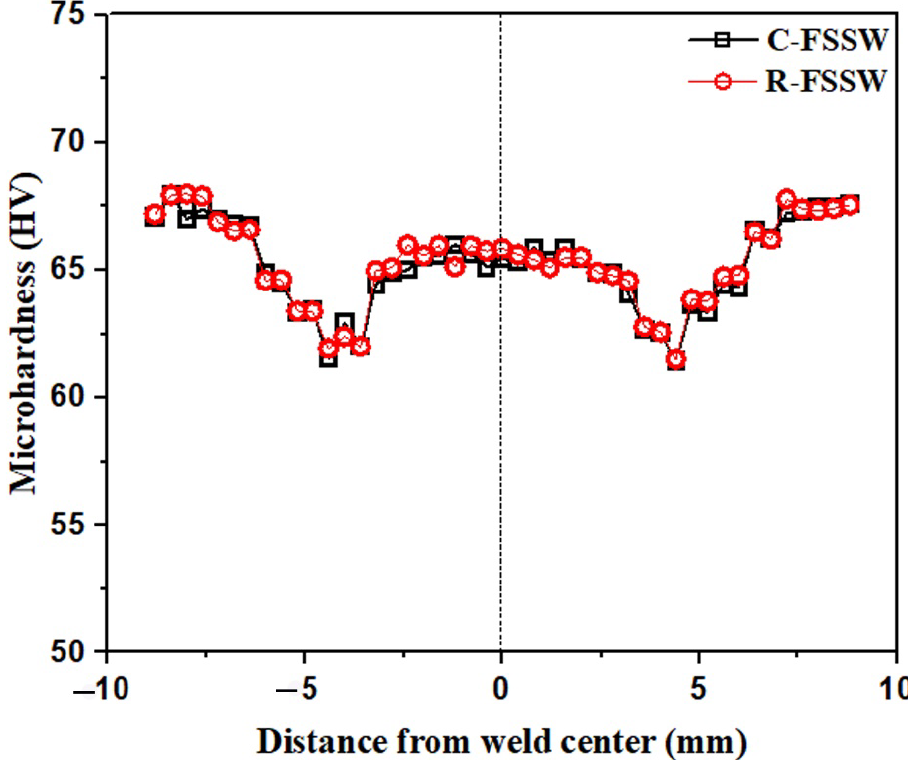
Figure 4. Hardness profile of the C-FSSW and R-FSSW joints across the weld interface. Under lap shear tests using the C-FSSW and R-FSSW methods, the close-up bottom views of the upper sheets and the close-up top views of the lower sheets are illustrated in Figures 6 and 7, respectively. In both the C-FSSW and the R-FSSW processes, two